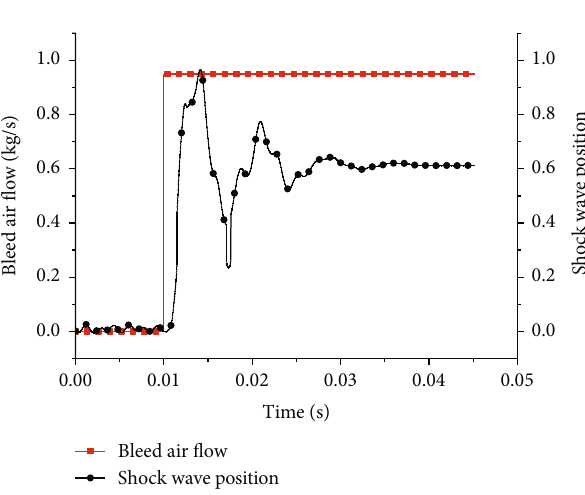
Figure 3: Inlet model.